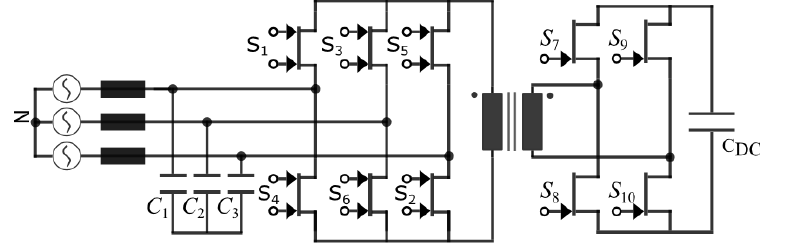
Figure 10. Matrix-type bi-directional three-phase AC/DC converter based on GaN transistors (de- rived from